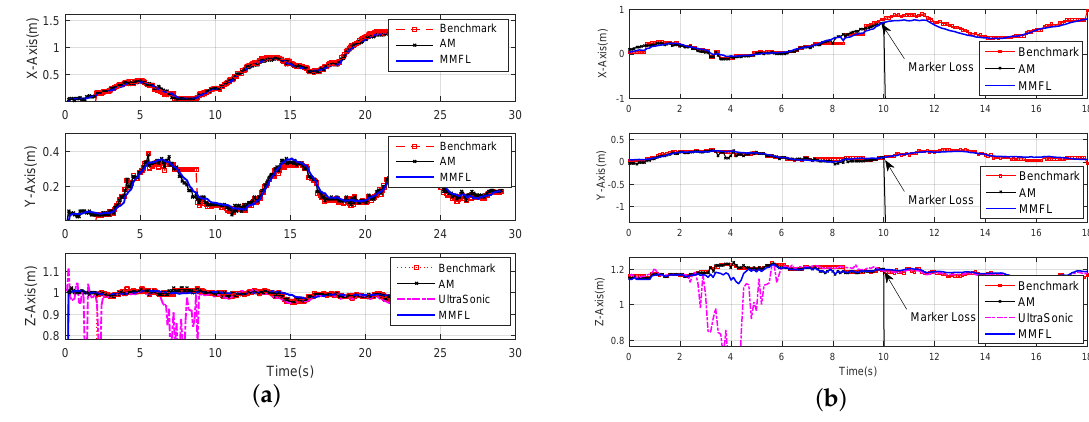
Figure 11. Position Fusion Result. ( a ) Without Marker Loss; ( b ) Marker Loss After the